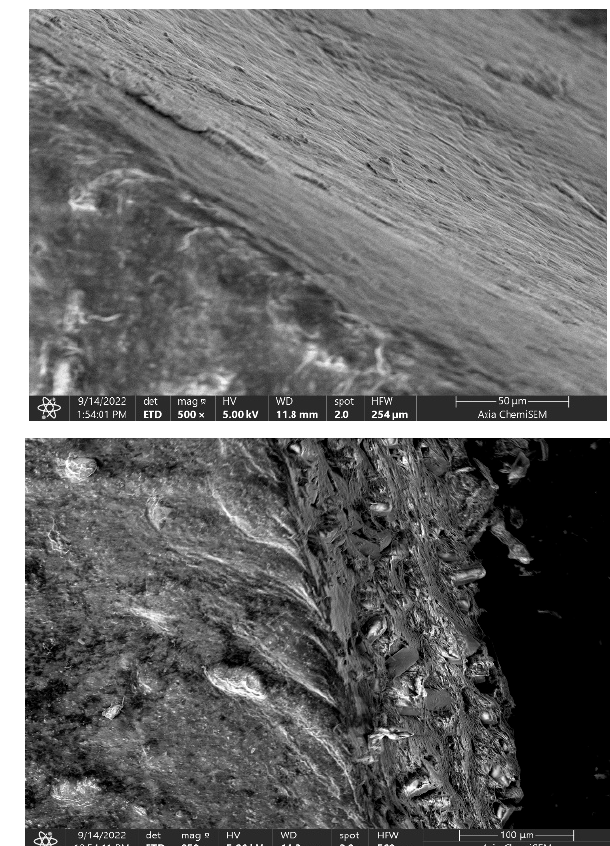
Figure 2. Optical microscope images ( left-hand side ) and length distribution of milled fibers ( right- hand side ) of ( a ) PLA–WG, ( b ) PLA–IPG, ( c ) PLA–HYBG, and ( d ) PLA–ARG composites.